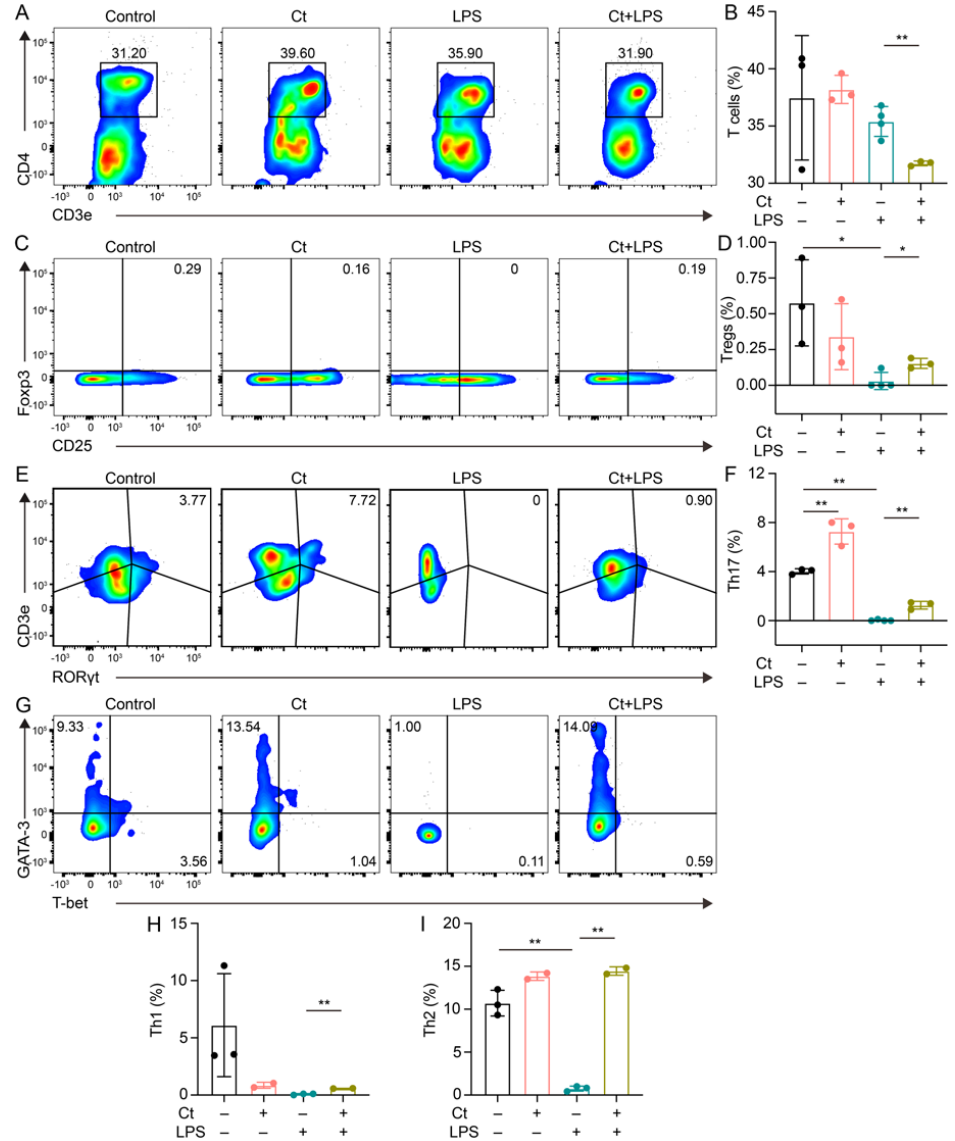
Figure 3. Effects of Ct on the proportion of T cells and its subsets in mice. ( A , B ) Proportion of T cells; ( C , D ) proportion of Tregs; ( E , F ) proportion of Th17 cells; ( G , I ) proportions of Th1 and Th2 cells. Each dot presented one mouse. Data presented as mean ± SEM. * p < 0.05, ** p < 0.01 by two-way unpaired t -tests.